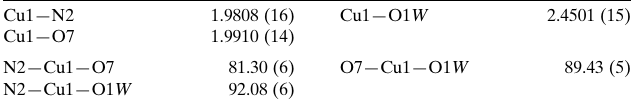
Selected geometric parameters (A˚ , (cid:3) ).